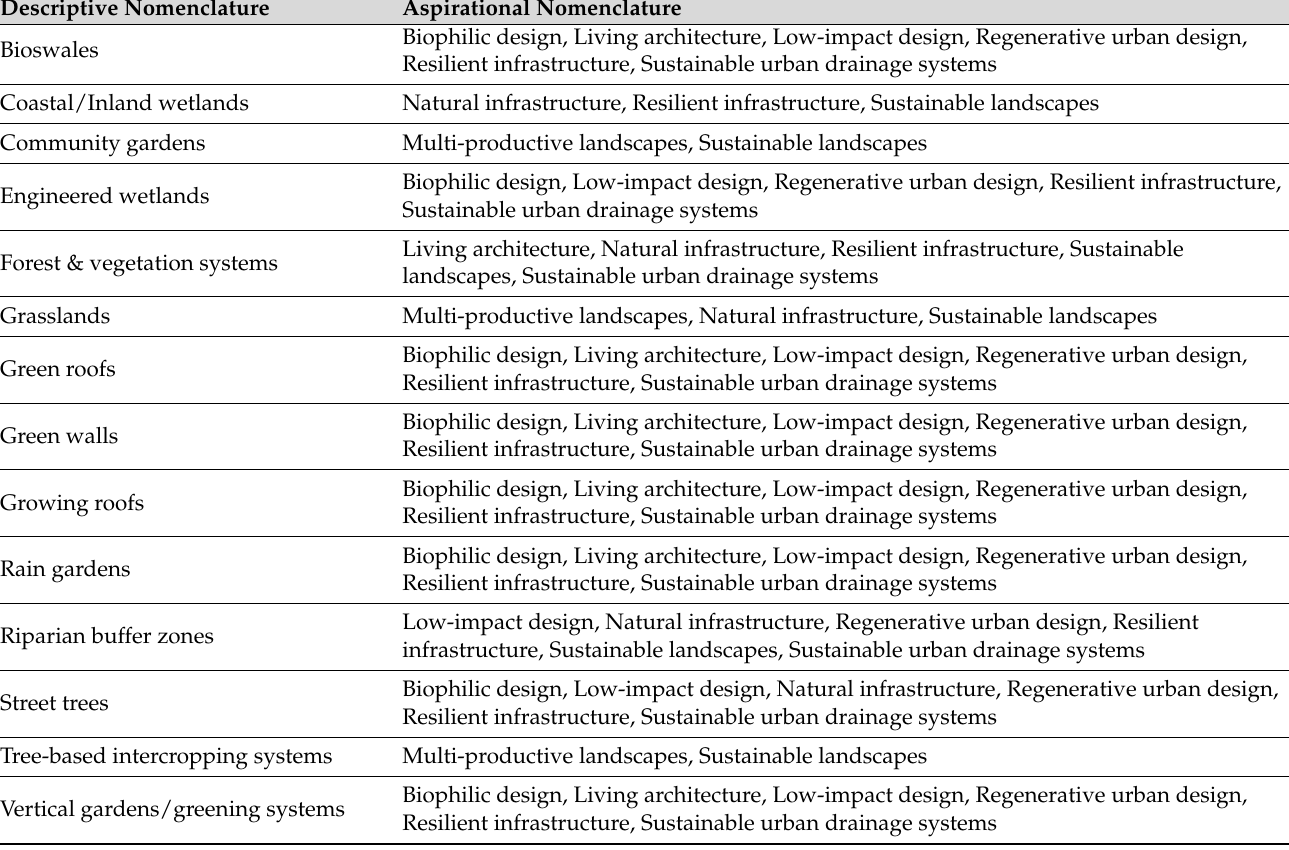
Table 3. Nomenclature comparison